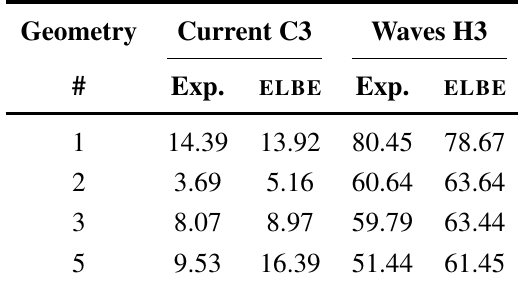
Table 4. Comparison of numerical results from the ELBE wave tank to experimental data [52]: horizontal forces, given in